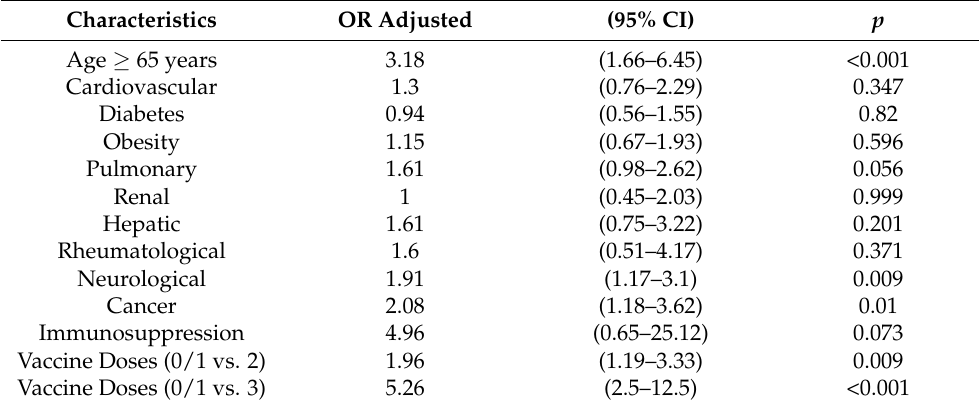
Table 7. Results of the multivariate logistic regression model predicting intensive care need in patients hospitalized during the fifth pandemic